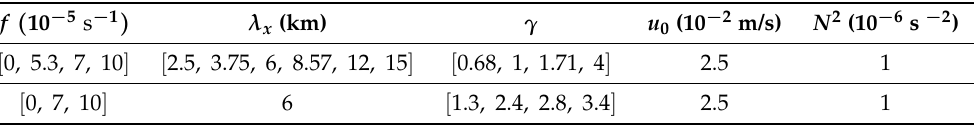
Table 2. Parameter sets for different